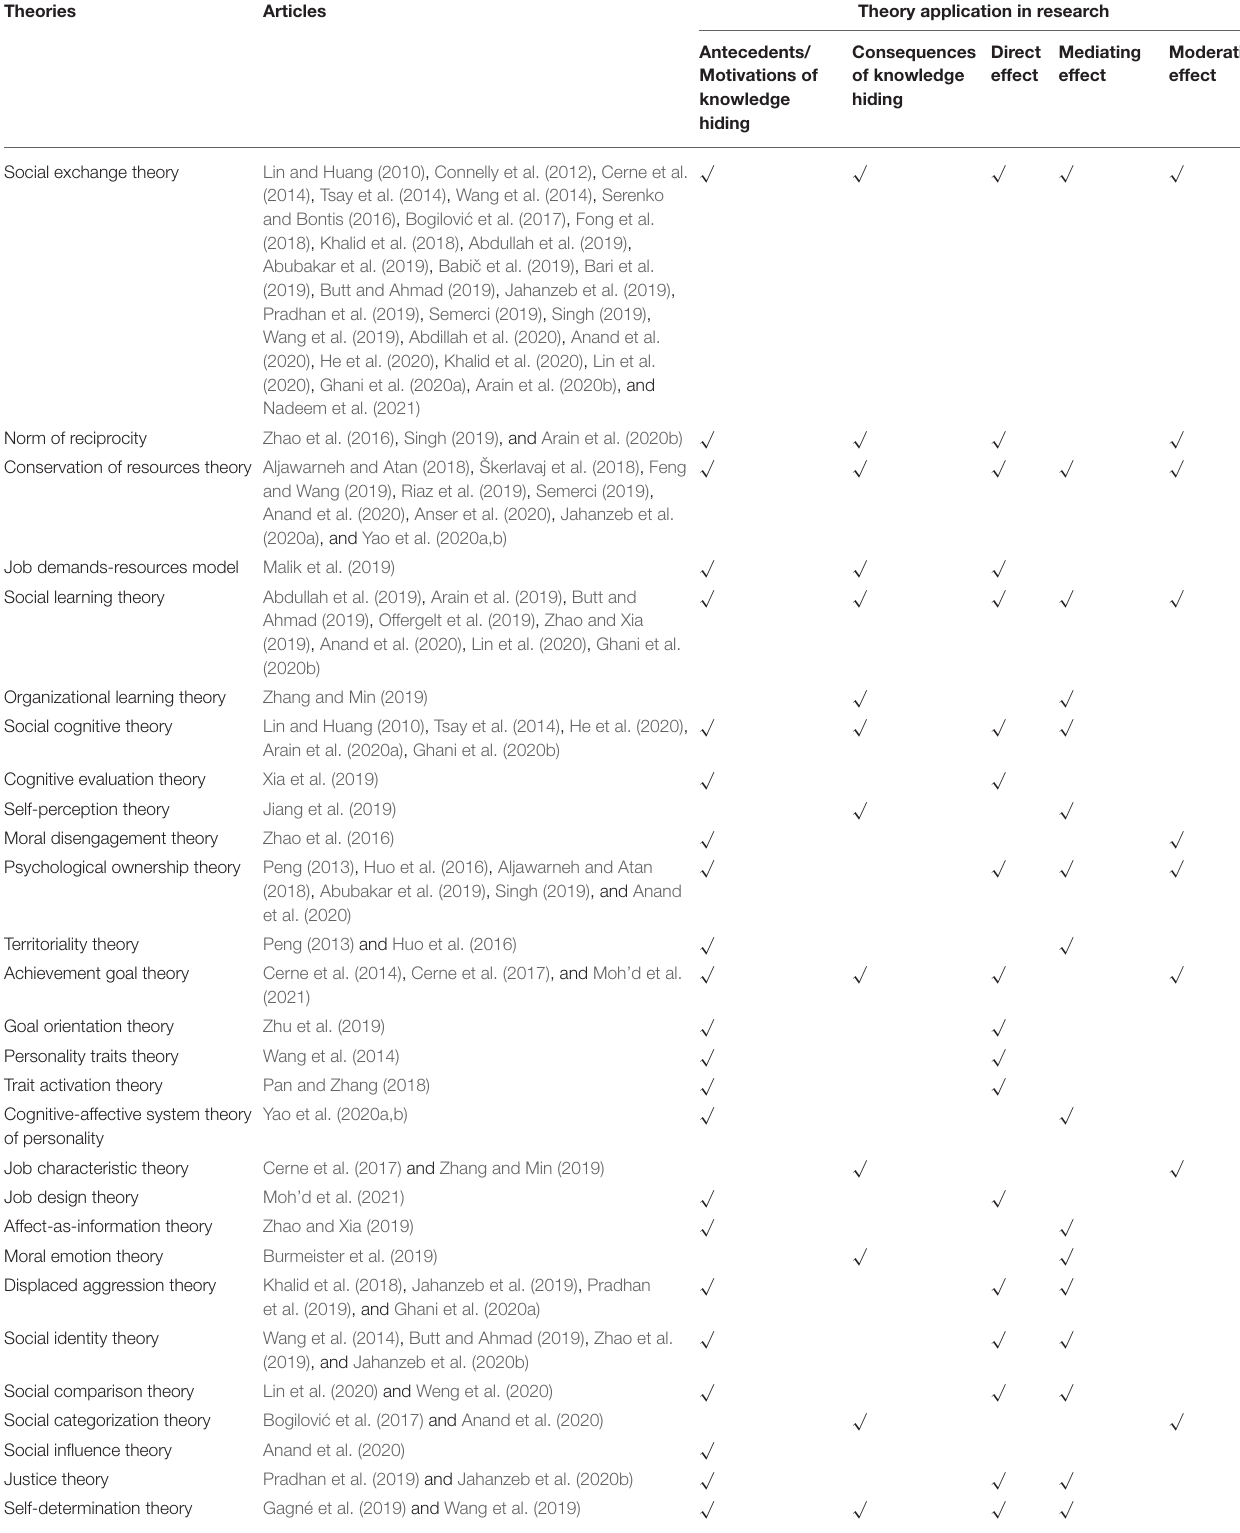
TABLE 6 | Theoretical perspectives used in knowledge hiding